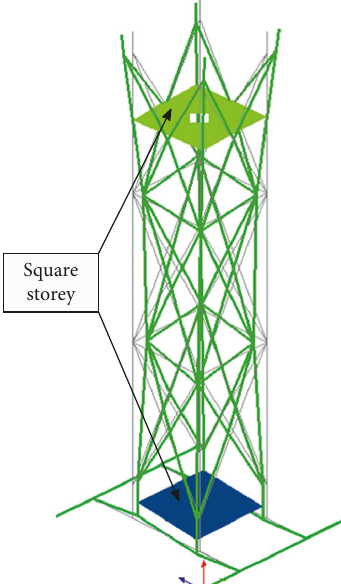
Figure 9: Mode shape at 70.6Hz, mode 11 of the measured set (note: angular distortion of the square storeys of the